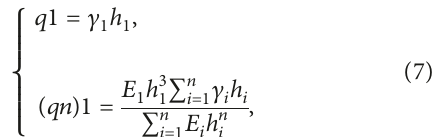
Figure 8: Strength curves of the floor